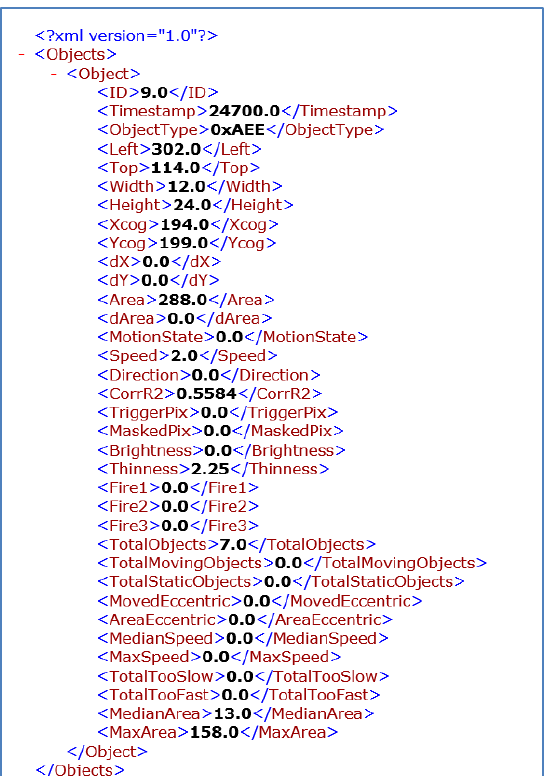
Figure 8. Example of XML